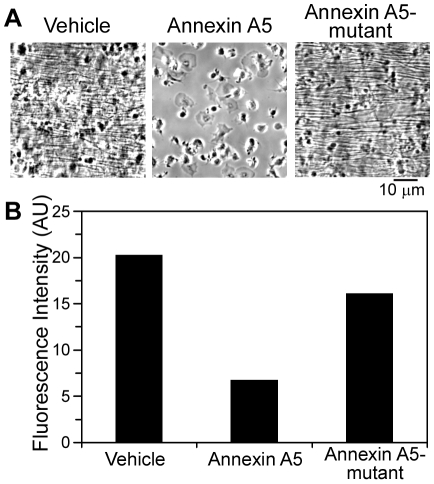
Role of PS-exposing platelets in fibrin formation during thrombus formation.Thrombi were formed on fibrinogen by co-perfusion of whole blood and CaCl2/TF at a shear rate of 200 s−1. Blood samples were incubated with vehicle, annexin A5, or mutant M1234 annexin A5 (each 0.28 µmol/L) before perfusion. Thrombi were labeled with OG488-fibrinogen (0.3 µmol/L). A, Representative phase-contrast micrographs of platelets and fibrin after 15 minutes of perfusion. B, Relative accumulation of labeled fibrin(ogen). Data are presented as integrated fluorescence intensity per microscopic field. Results of one representative experiment are shown.